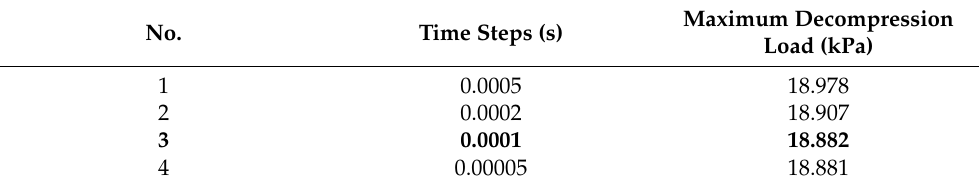
Table 3. Time-step-independence verification of 0-D model.